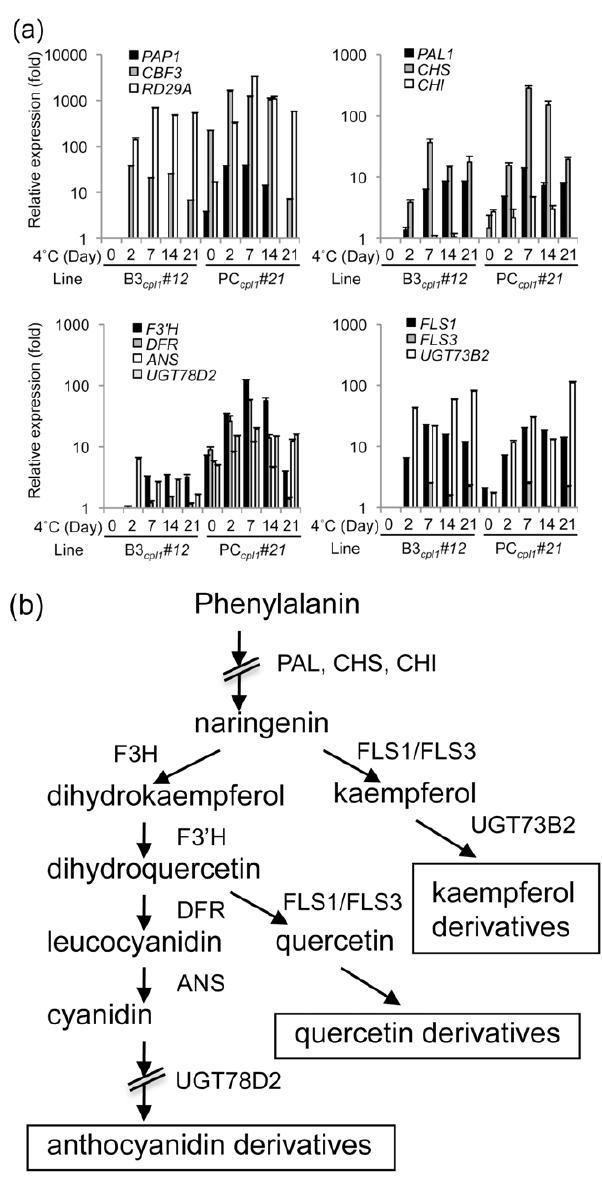
Figure 4. Time-course expressions of transgene and flavonoid biosynthetic pathway genes in B3 cpl1 and in PC cpl1 lines during cold treatment. (a) Total RNAs were extracted from leaves of 3-week- old plants grown at room temperature (23 u C) and plants treated with cold (4 u C) for additional 2 days, 1 week, 2 weeks and 3 weeks. Expression levels of each gene were shown relative to the levels of B3 cpl1 grown at 23 u C. Bars indicate standard errors. Experiments were conducted two times with similar results. Results from one experiment were shown. PAL1 ; phenylalanine ammonia lyase 1, CHS ; chalcone synthase, CHI ; chalcone isomerase, F3 9 H ; flavonoid 3 9 -hydroxylase, DFR ; dihydroflavonol reductase, ANS ; anthocyanidin synthase, FLS1 ; flavonol synthase 1, FLS3 ; flavonol synthase 3, UGT73B2 ; UDP-glucosyltransferase 73B2 (flavonol 3-O-glucosyltransferase activity), UGT78D2 ; UDP-gluco- syltransferase 78D2 (anthocyanidin 3- O -glucosyltransferase). (b) Struc- ture of phenylpropanoid pathway. Transcript levels of the enzymes in the marked steps were analyzed in